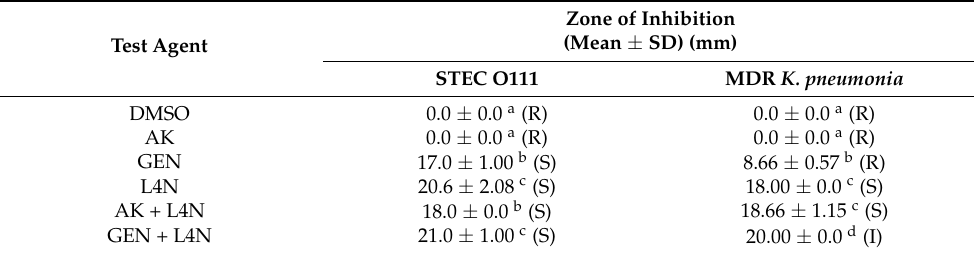
Table 1. Inhibition zones of antibiotics and luteolin 4 (cid:48) -neohesperidoside (L4N) in regard to MDR Gram-negative bacteria (STEC O111 and MDR K. pneumoniae ).